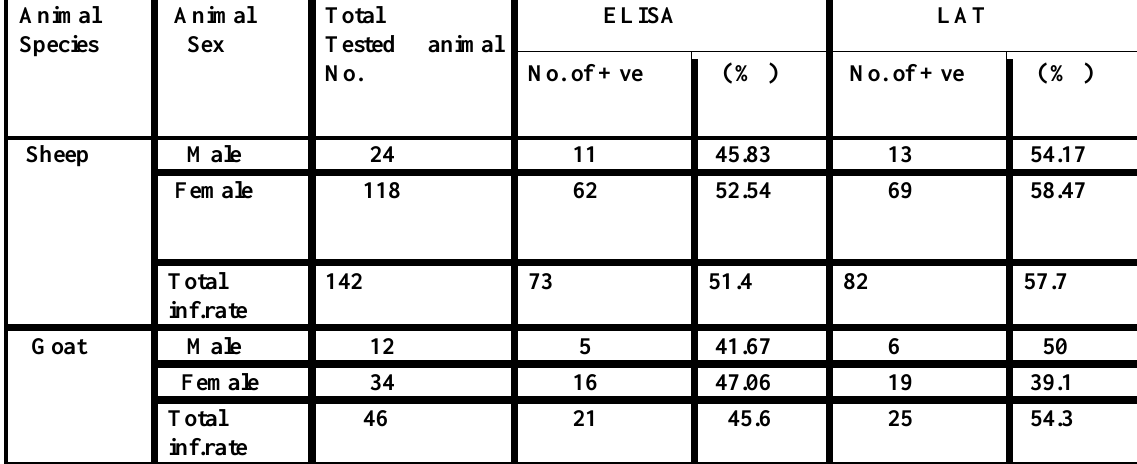
Table (1) Prevalence of toxoplasmosis in both species of sheep and goats by ELISA and LAT.